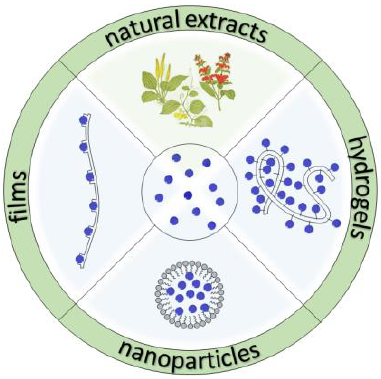
Figure 2. Schematic drawing of antioxidant molecules (central circle) extracted from natural sources (top panel) and exploited for preparing films (left panel), hydrogels (right panel), and nanoparticles (bottom panel) able to reduce the oxidative stress.